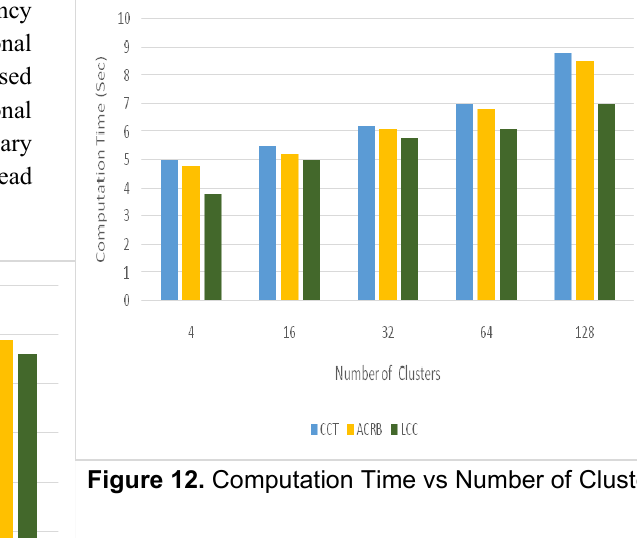
Figure 12. Computation Time vs Number of